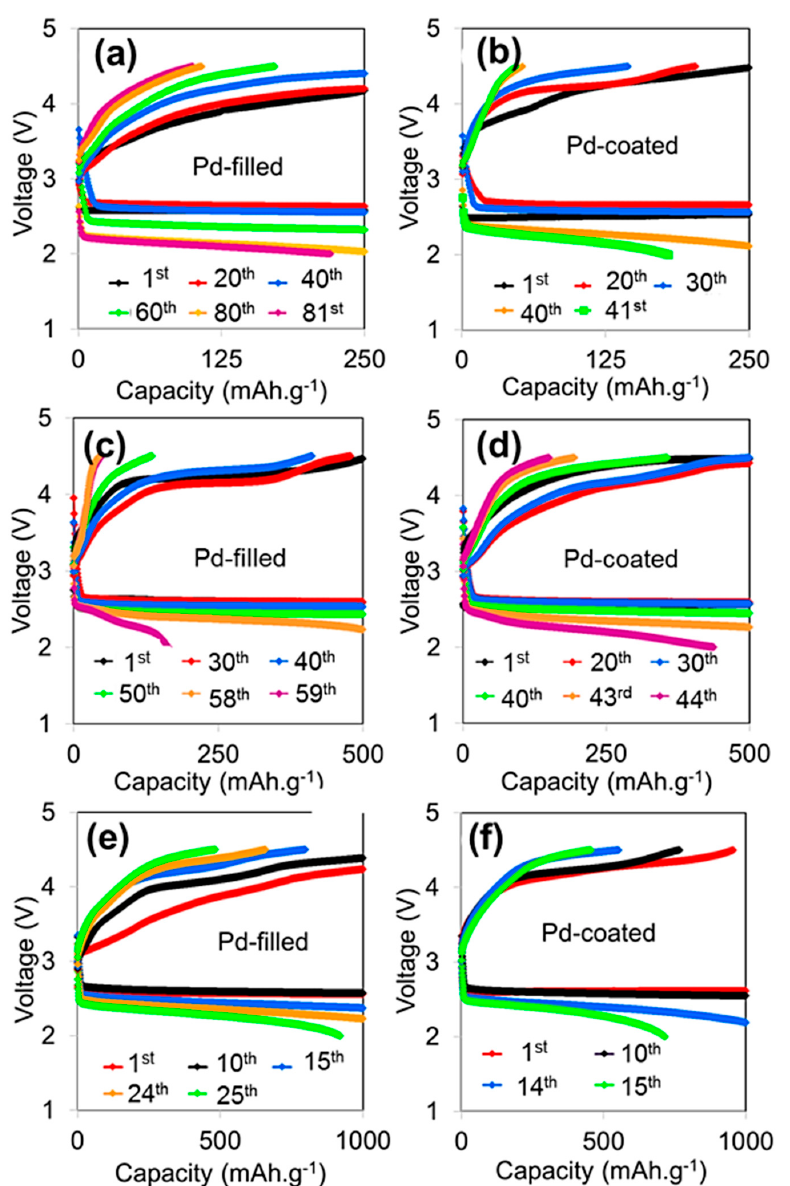
Figure 1. Voltage profile of lithium-oxygen (Li − O 2 ) batteries with ( a , c , e ) palladium-filled and ( b , d , f ) palladium-coated carbon nanotubes (CNTs) at fixed capacities of 250 mAh.g − 1 , 500 mAh.g − 1 , and 1000 mAh.g − 1 , respectively, at a 250 mA.g − 1 current density between 2.0 to 4.5 V.